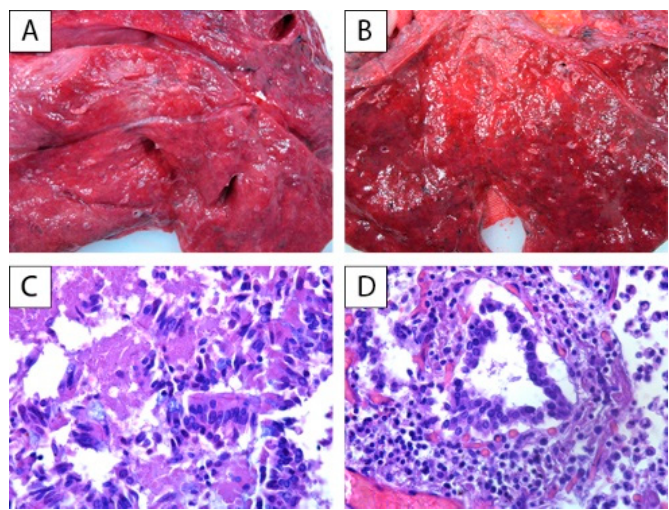
Figure 2. Group B: pulmonary macroscopic and microscopic findings: ( A , B ) cherry-red coloration, pulmonary edema, and congestion; compact basal parenchyma; ( C ) desquamative necrosis of the bronchial epithelium, H&E, 400×; ( D ) bronchi surrounded by inflammatory cells, H&E, 400×.